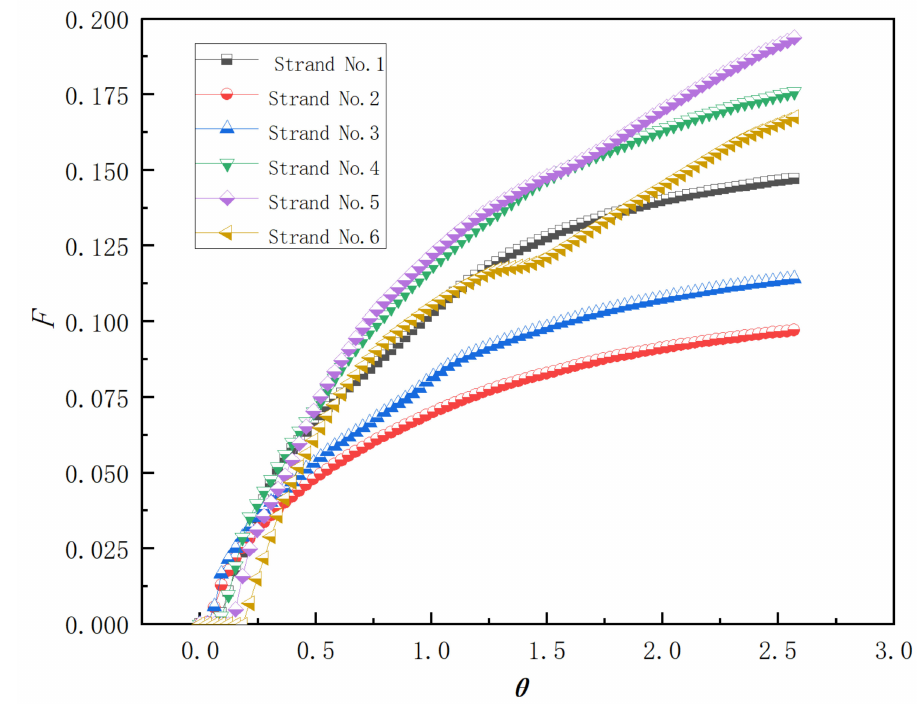
Figure 10. F -curve of each strand.